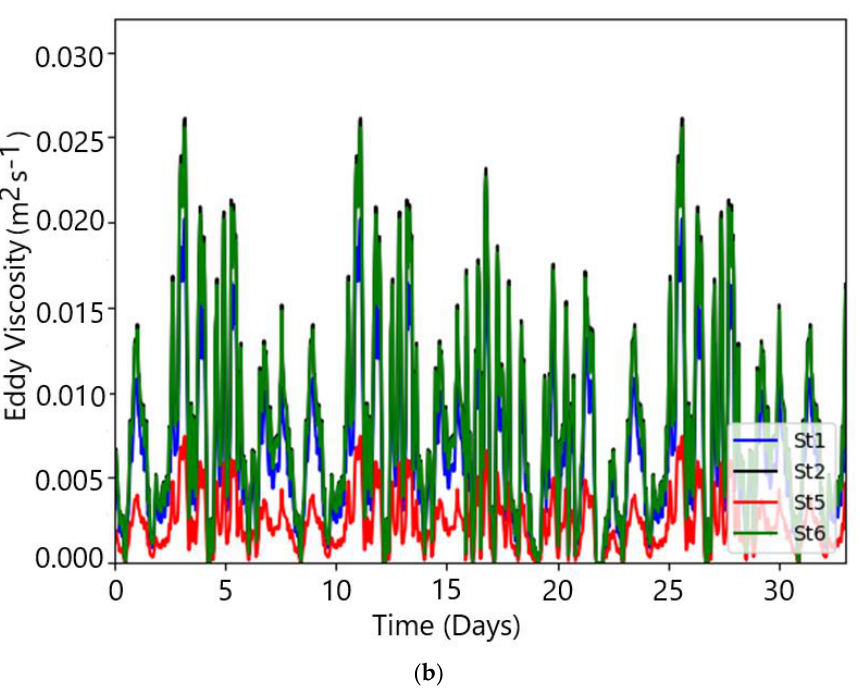
Figure 2. ( a ) Simulated horizontal eddy viscosity for St1, St2, St5, and St6. ( b ) Simulated vertical eddy viscosity for St1, St2, St5, and St6.